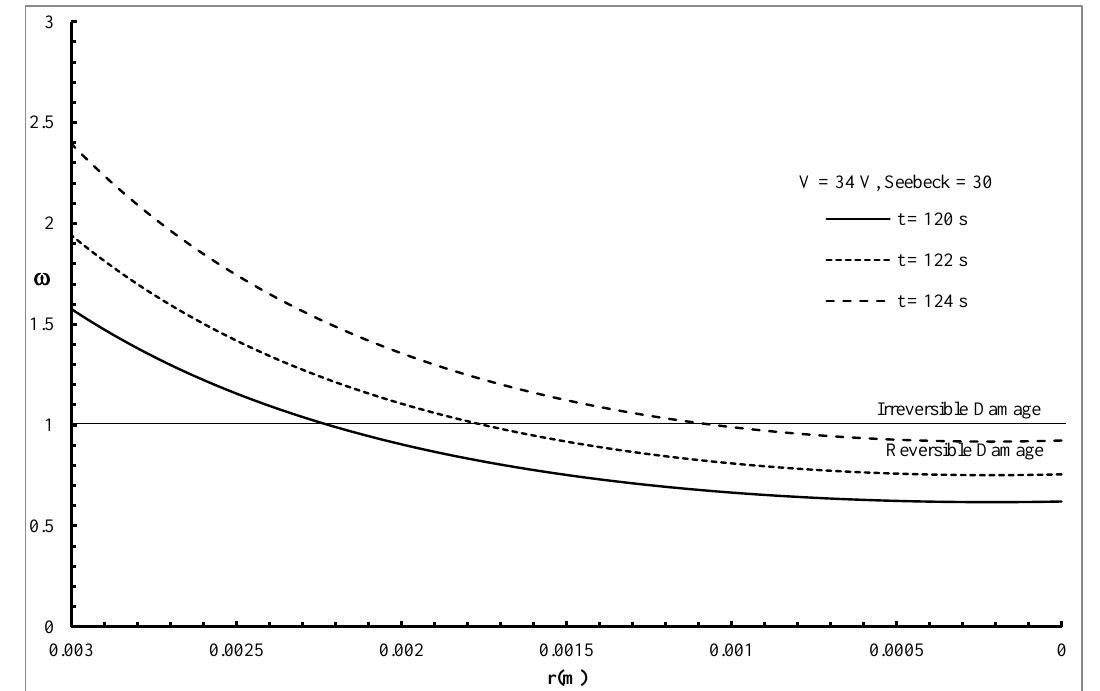
Figure 14 . The thermal damage distribution of myxoid liposarcoma tumor with various values of Figure 14. The thermal damage distribution of myxoid liposarcoma tumor with various values of time R   . time when 75 when R e = 75 Ω . Mathematics 2020 , 8 , x FOR PEER REVIEW e